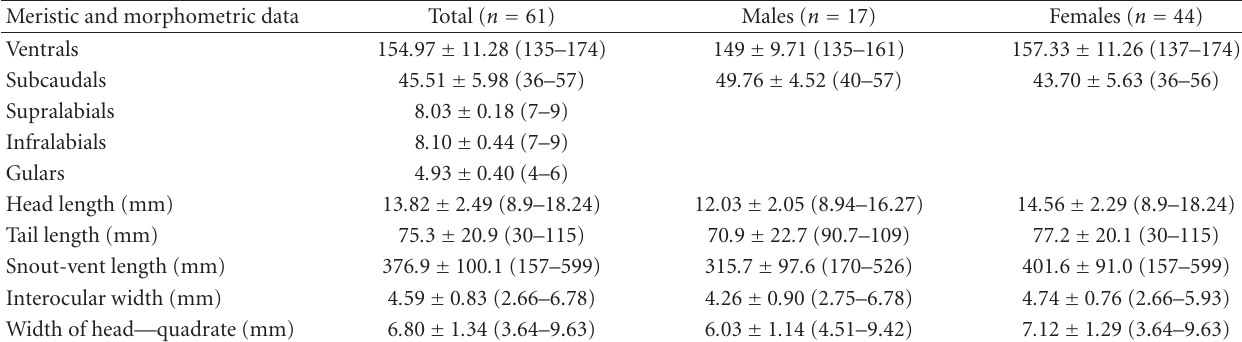
Table 1: Meristic and morphometric variation of Sordellina punctata . Data expressed by mean ± standard deviation (amplitude).